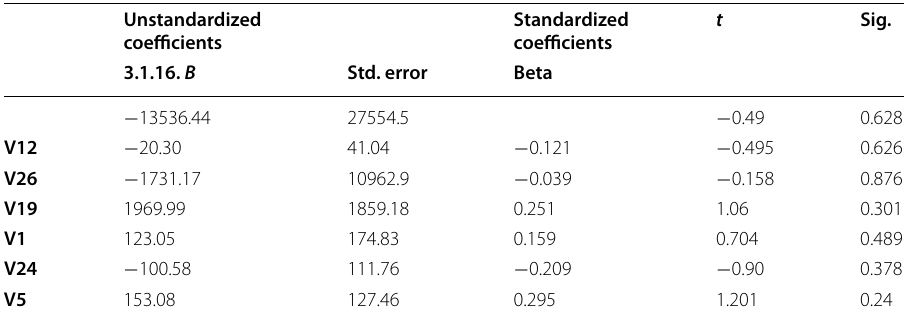
Table 12 Regression results for factor 3